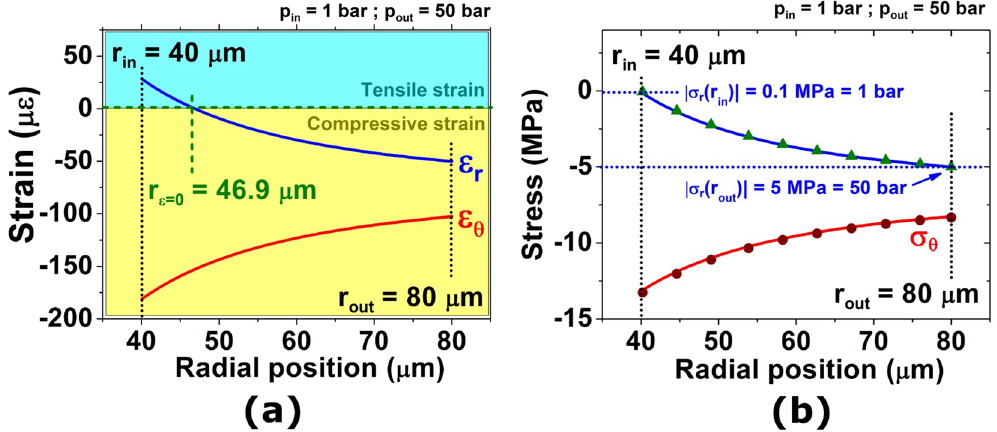
Figure 2. Strain and stresses within capillary fibre wall. ( a ) Strain and ( b ) stress as a function of the radial position for a capillary fibre with r in = 40 μ m and r out = 80 μ m under an external pressure of 50 bar and inner pressure level of 1 bar. Green triangles and dark red circles are the results obtained from the COMSOL ® numerical